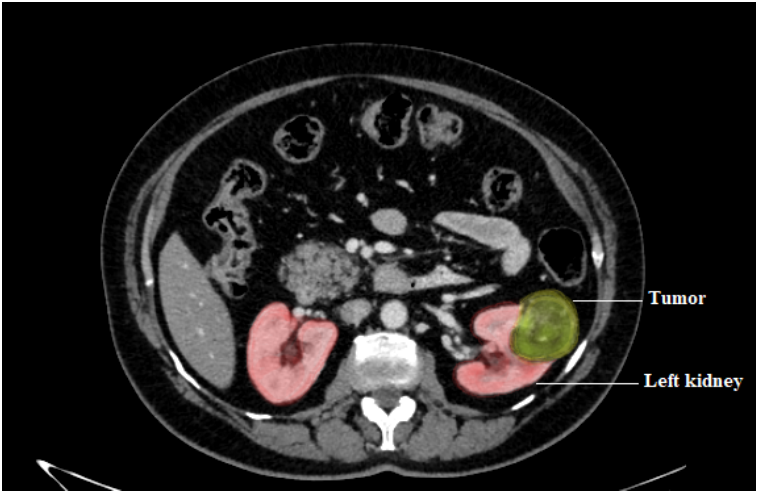
Figure 16. Kidney tumor segmentation. Table 5. The outcomes of the related segmentation tumor